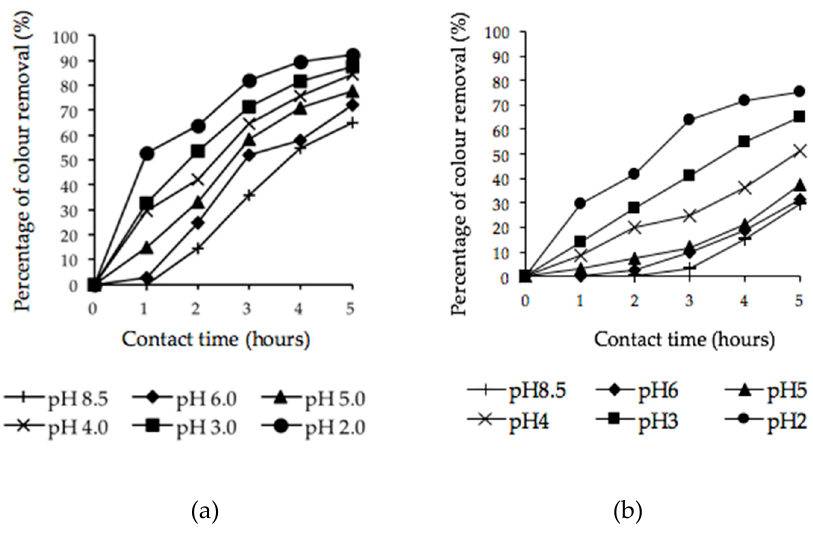
Figure 5. Percentage of color removal for POMB-retained ash: ( a ) microwave irradiated and ( b ) H 2 SO 4 – microwave irradiated at different pHs.